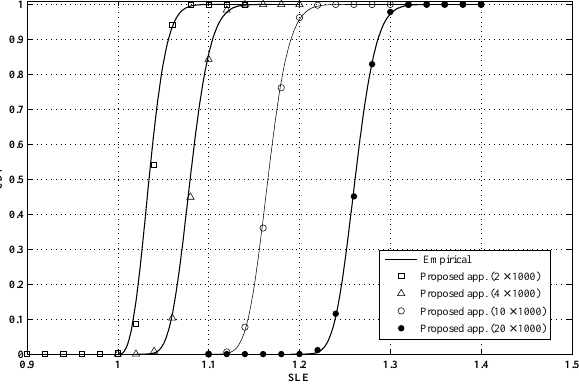
hypothesis and 0